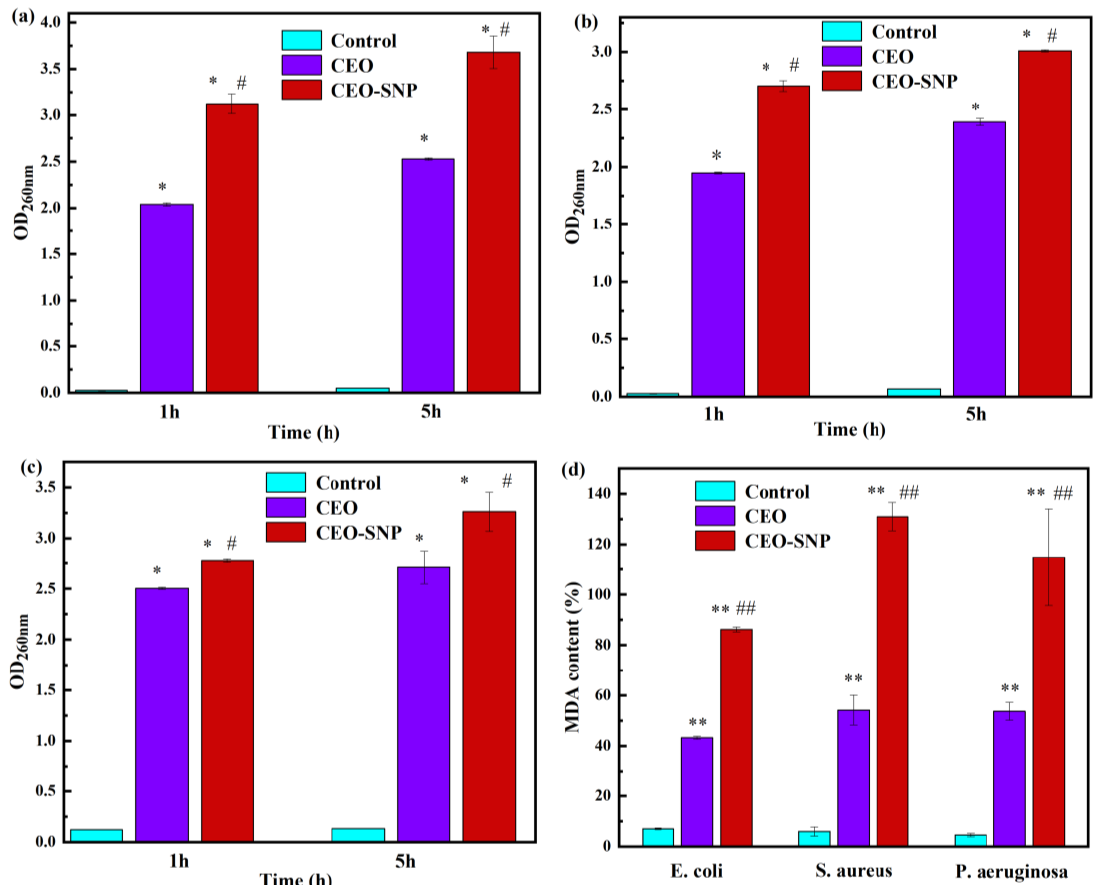
Figure 9. Nucleic acid contents of E. coli ( a ), S. aureus ( b ) and P. aeruginosa ( c ) suspensions after being treated by CEO and CEO−SNP, respectively. MDA content ( d ) of E. coli , S. aureus and P. aeruginosa after being treated by CEO and CEO-SNP, respectively. Values were expressed as mean ± S.D. ( n = 3). * ( p < 0.05) and ** ( p < 0.01) represented the significant difference compared with control group; # ( p < 0.05) and ## ( p < 0.01) represented the significant difference between CEO-SNP and CEO group.